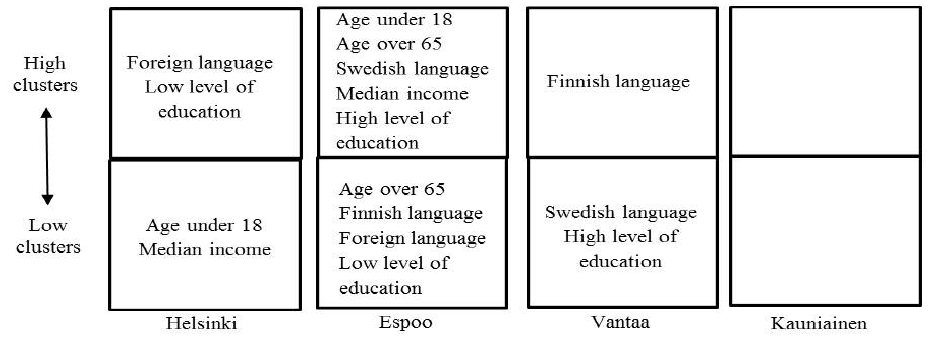
Fig. 3. Cluster distribution according to count frequency in the municipalities of Helsinki Metropolitan Area (HMA).